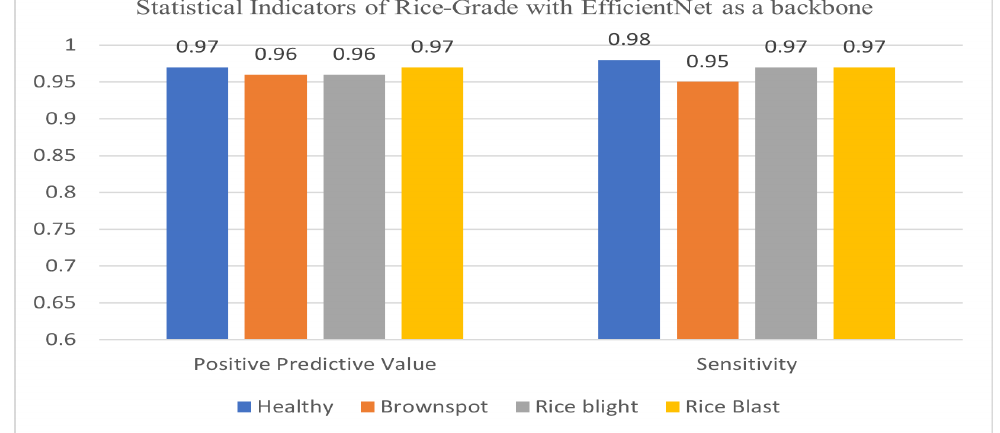
Figure 10. PPV, sensitivity, and DSC of proposed model using EfficientNet-B0 backbone architecture.